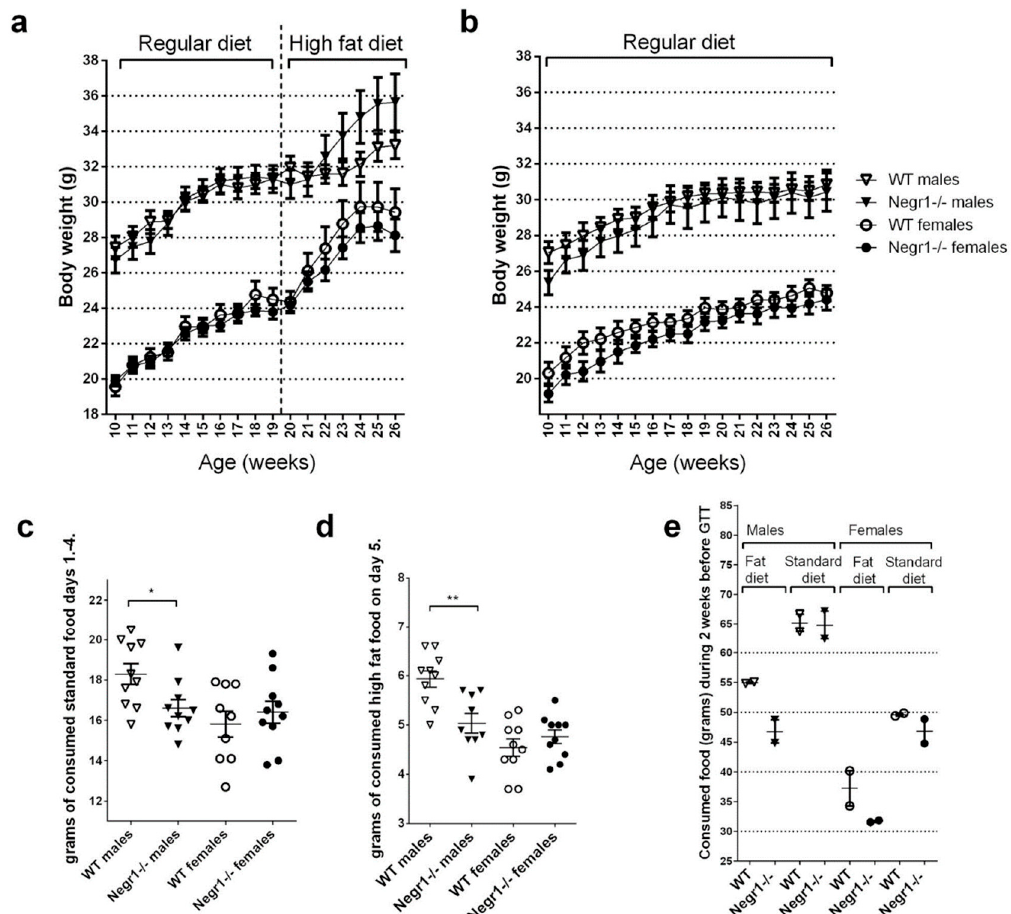
Figure 2. Body weight dynamics and food intake measurements. The body weight of the first batch of mice was measured 10 weeks before the beginning of the high-fat (HF) diet. Mice received the HF diet for 7 weeks. Body weight dynamics of ( a ) HF diet groups and ( b ) standard chow group. Daily food intake measurements in single-housed mice prior to the food preference test showed that ( c ) WT males consumed significantly more standard food (days 1–4). ( d ) WT males also consumed significantly more HF food during the food preference test (day 5) compared to the Negr1 − / − mice. ( e ) Food consumed (grams) for 2 weeks (14 days) before the glucose tolerance test in the second batch of mice. The data points were calculated as food consumed per group of mice (n = 5 per group). Data represent mean ± SEM. * p ≥ 0.05, ** p ≥ 0.01 (Mann– Whitney U-test).